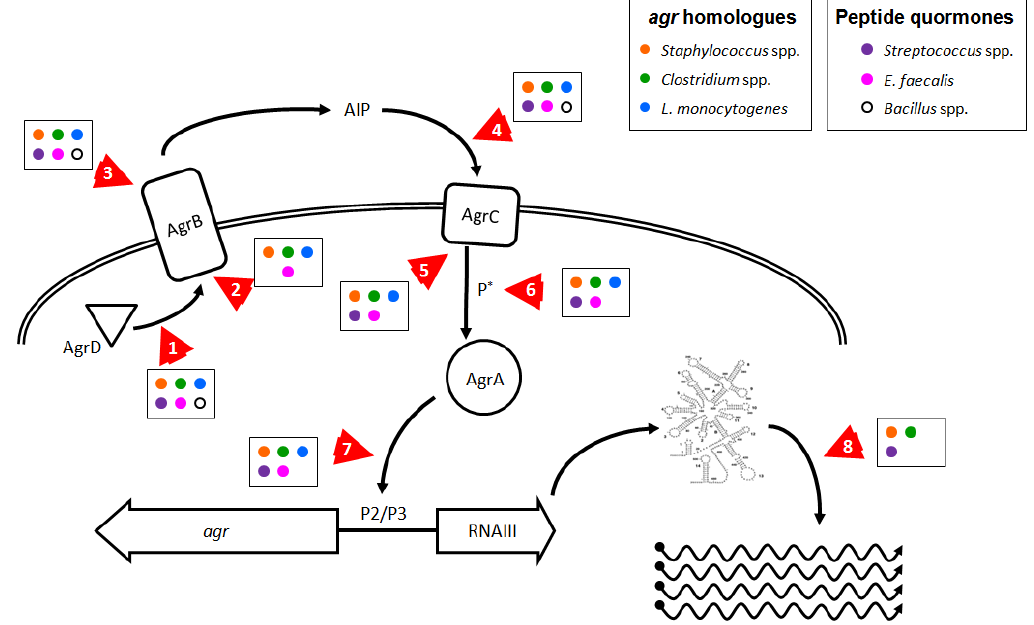
Figure 3. Known targets in agr -homologues and other peptide quormone QS systems with the potential for chemotherapeutic intervention to inhibit or retard virulence. Colored dots indicate which species are reported to possess agr homologues or analogues at the